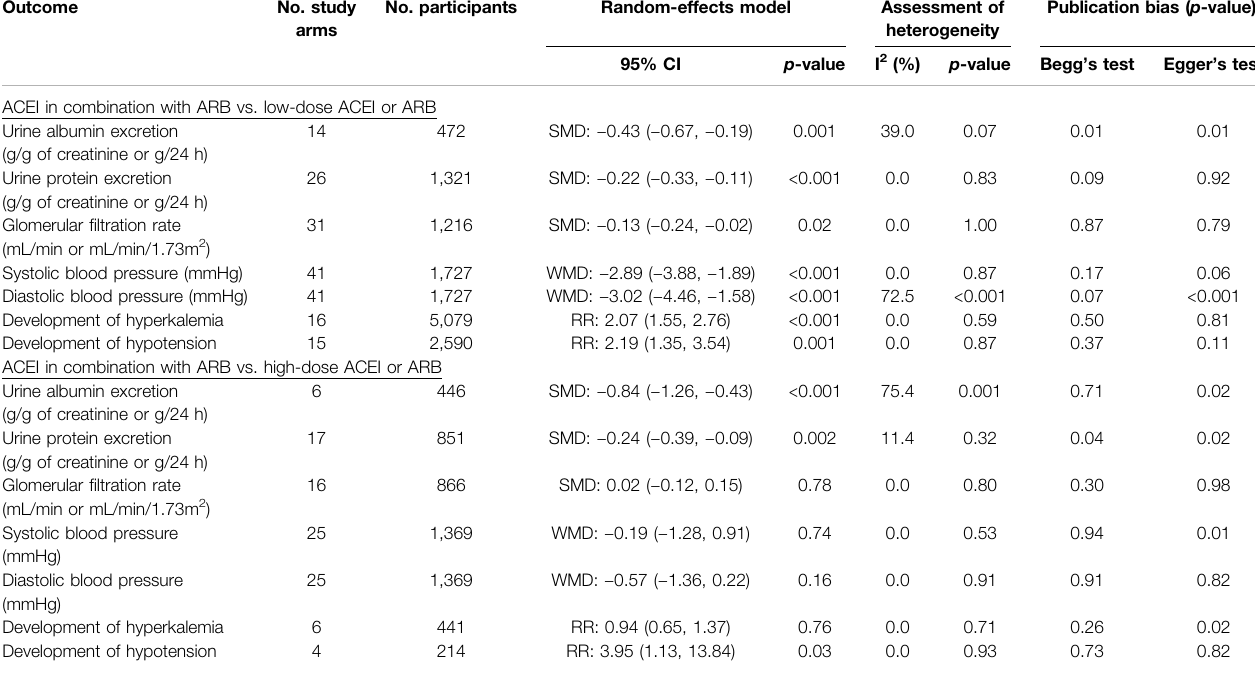
TABLE 2 | Summary effect of ACEI in combination with ARB vs. ACEI or ARB. Outcome No. study